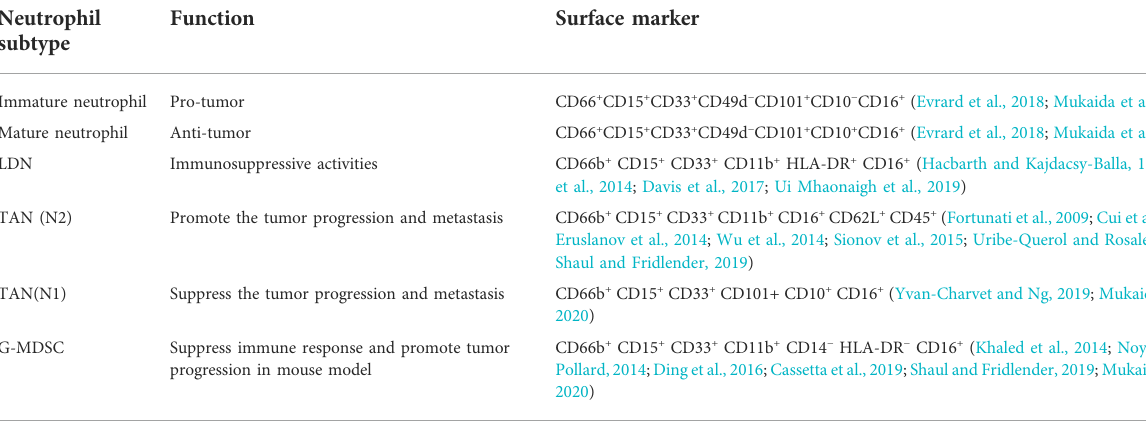
TABLE 1 Main surface markers and function of LDNs, TANs, and G-MDSCs, immature neutrophil and mature